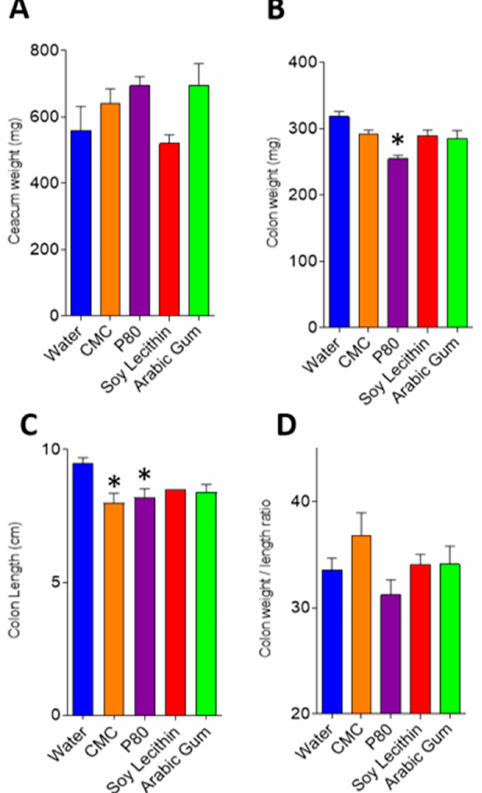
Figure 1. ( A – D ): Intestinal weight and length in emulsifier and water-treated mice. Graphs depict mean and standard error for caecal weight ( A ), colon weight ( B ), colon length ( C ) and colon weight / length ratio ( D ). * p < 0.05 compared with water (control) following ANOVA and Bonferroni post hoc correction. CMC, carboxymethylcellulose; P80,